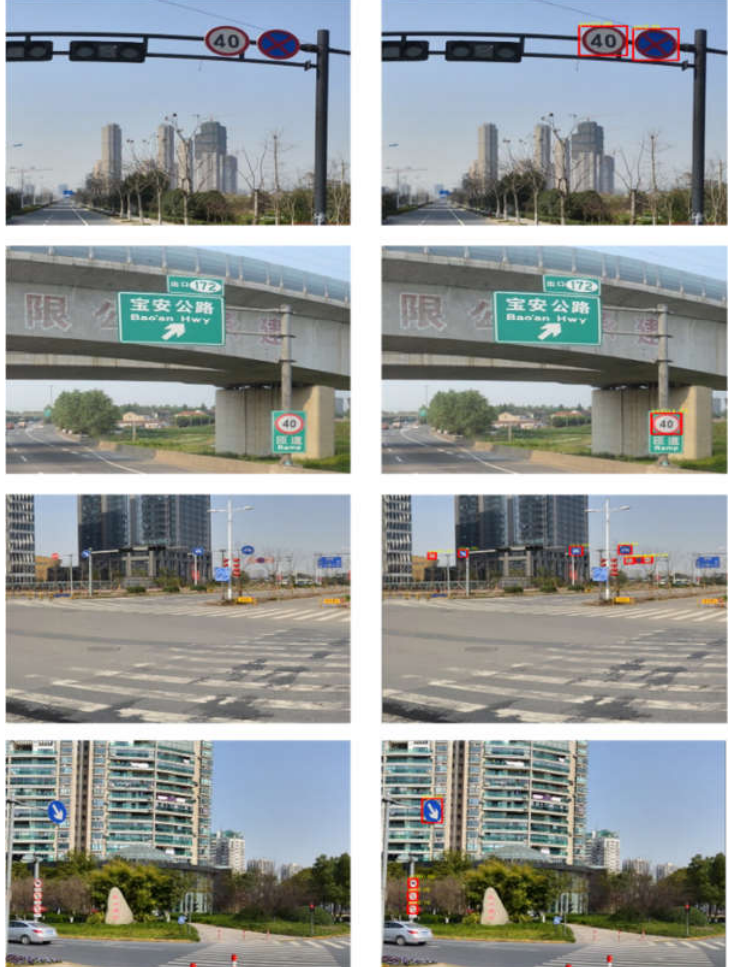
Figure 13. Images demonstrating the effect of improved Faster R-CNN detection (images on the left are the original images, and those on the right are the detection